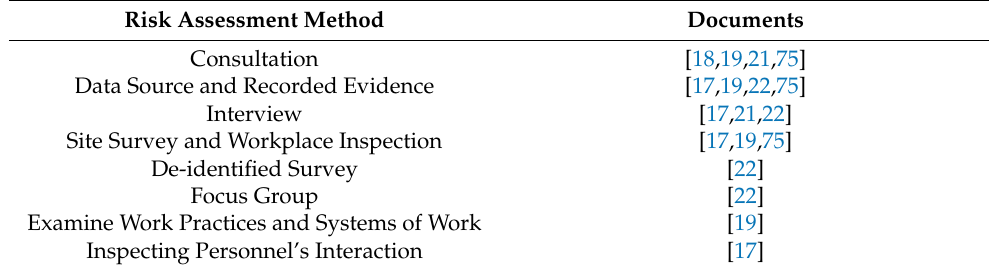
Table 5. Suggested mental risk assessment methods in the retrieved laws, regulations, and codes of